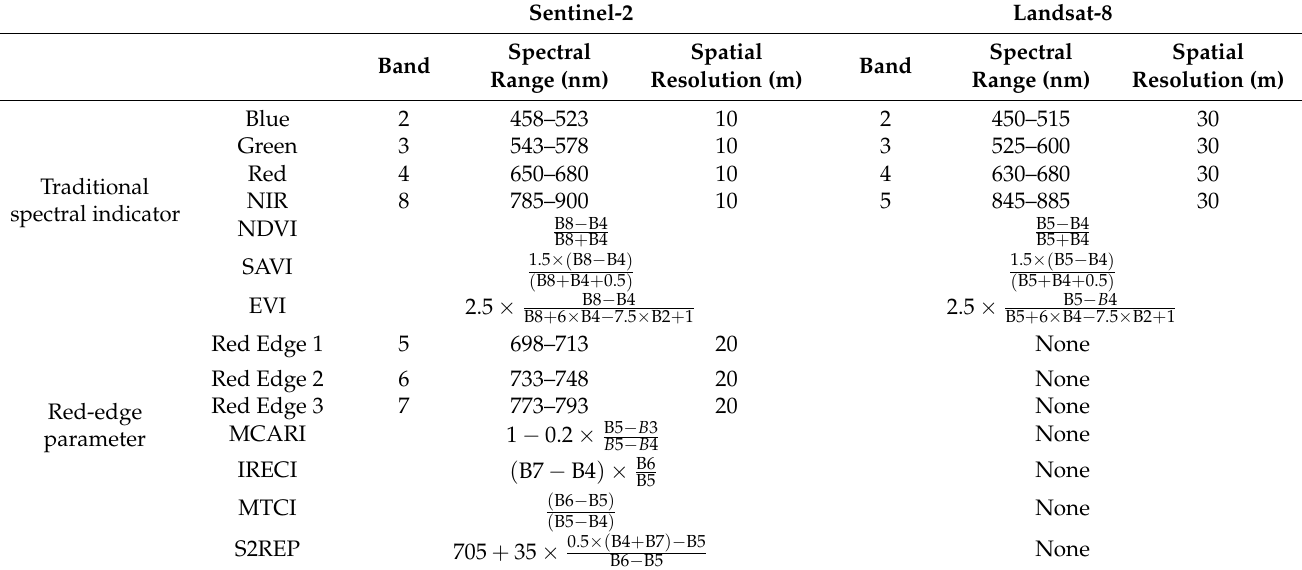
Table 2. Remote sensing variables